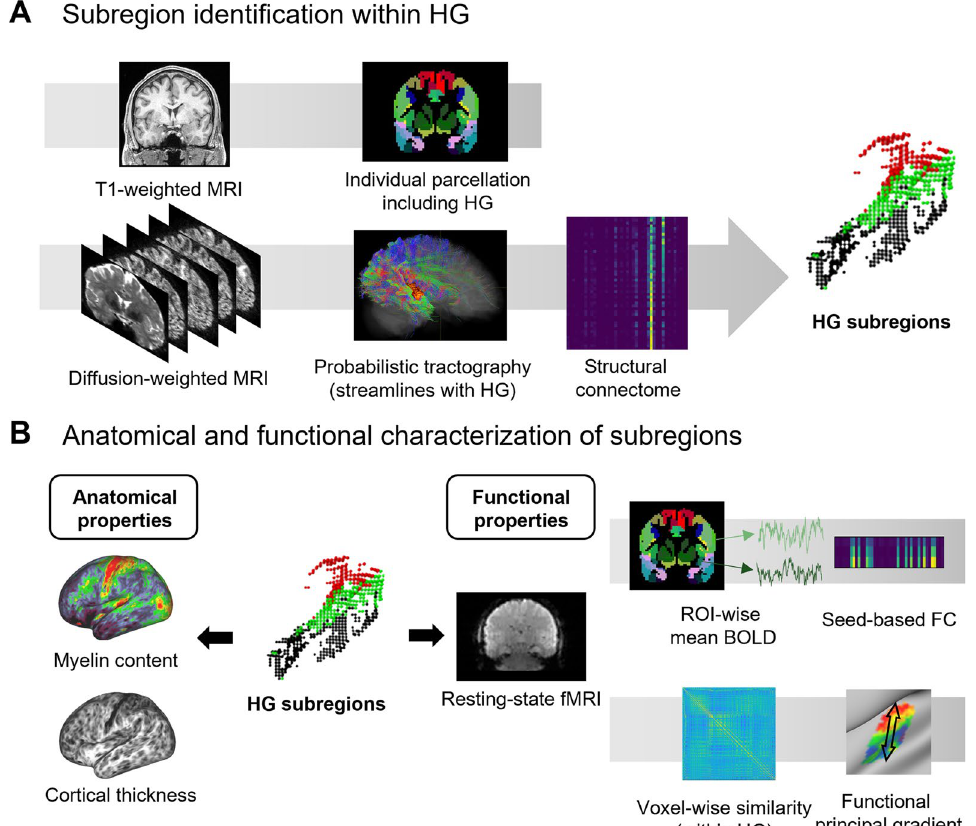
Figure 1. Flowchart of the study. ( A ) Individual-level parcellation was performed using T1-weighted MRI to define the HG. Subregions were identified via clustering approaches using seed-based structural connectivity information with the seed of the individual HG. ( B ) We characterized anatomical (i.e., myelin contents and cortical thickness) and functional properties (i.e., functional connectivity and gradient) of the HG